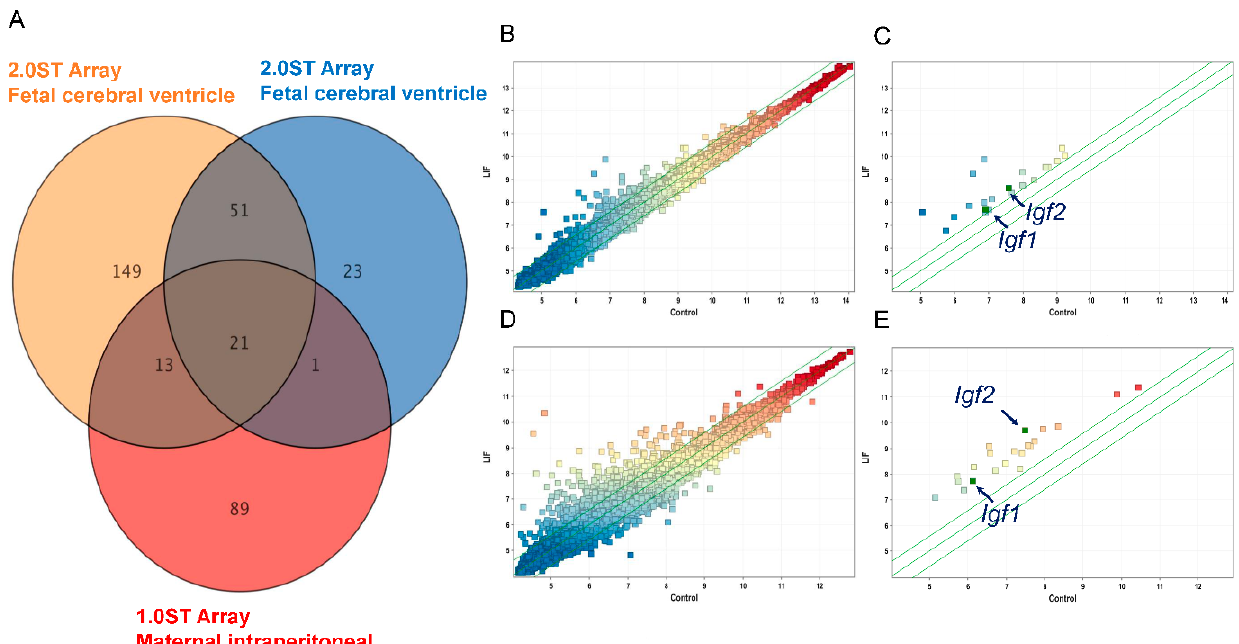
Figure 1. DNA microarray analysis in the fetal cerebrum at E14.5 after LIF injection into the peritoneal cavity of dams or cerebral ventricles of fetuses. LIF injection into dams intraperitoneally or fetal cerebrum ventricle directly increased Igf1 and Igf2 gene expressions in the fetal dorsal cerebrum at E14.5 rat fetuses: ( A ) The number of common differentially expressed genes (DEGs) between LIF injection into dams intraperitoneally and fetal cerebrum ventricle directly (|Fold Change (FC)| > 1.5) is shown. ( B , C ) the peritoneal injection to dams cohort included LIF- (n = 1) and saline- (n = 1, as control) injected animals. ( D , E ) The intracerebroventricular injection to fetuses cohort included LIF- (n = 2) and PBS- (n = 3, as control) injected animals. Among the upregulated DEGs, we focused on Igf1 and Igf2 . Pairwise scatter plots are shown, and 21 DEGs were identified based on the cut-off criteria (|Fold Change (FC)| > 1.5). The positions of Igf1 and Igf2 are indicated by black arrows. Table 1. Extracted differentially expressed 21 genes with fold change (FC) > 1.5 from the dataset of DNA microarray analysis screened by Pairwise scatter plots.